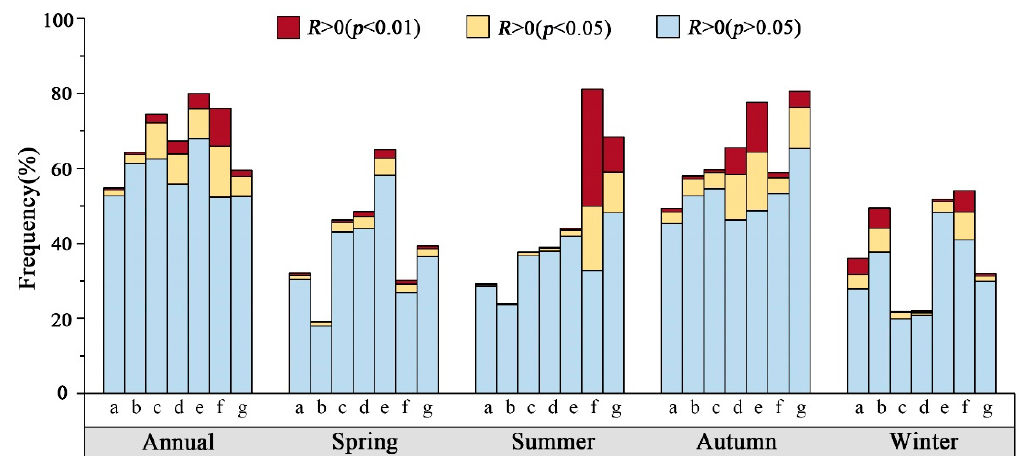
Figure 6. Frequency distribution of the areas with positive correlation ( R > 0) between gross primary productivity (GPP) and standardized precipitation evapotranspiration index (SPEI) for different vegetation types, including (a) evergreen forests, (b) deciduous forests, (c) mixed forests, (d) woody savannas, (e) savannas, (f) grasslands, and (g) croplands under different temporal scales (annual and seasonal) across China from 2001 to 2020.